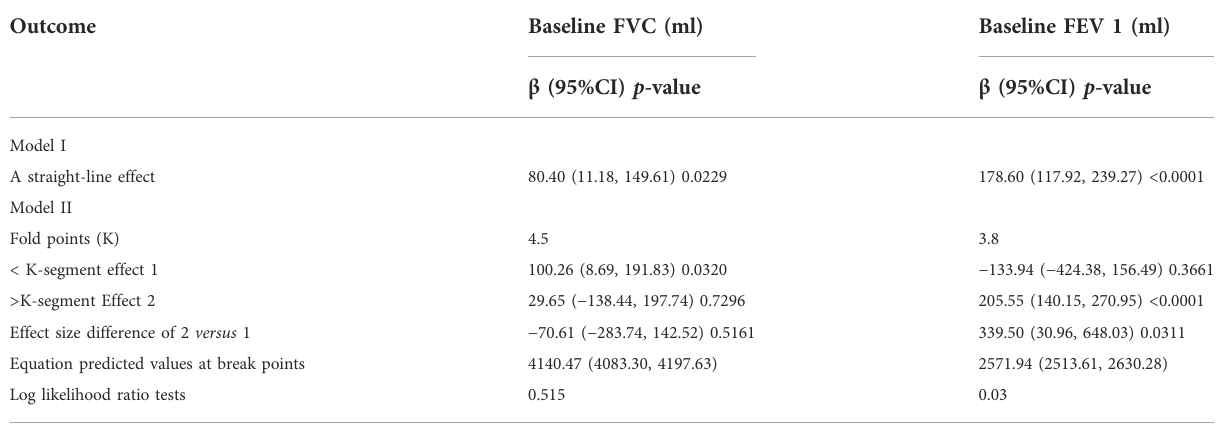
TABLE 4 Analysis of threshold effect and saturation